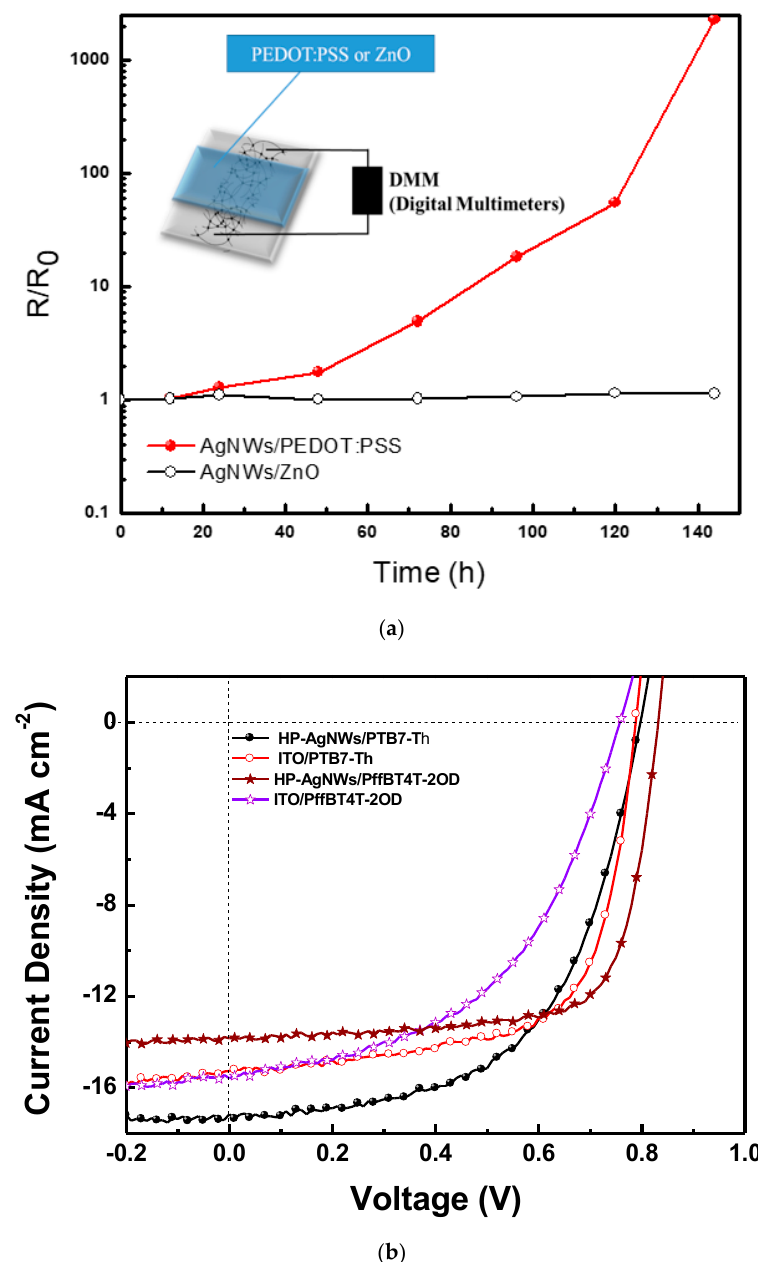
Figure 4. ( a ) Variation in R s of HP-AgNW/PEDOT:PSS and HP-AgNW/ZnO films under long-term storage in air; ( b ) J - V curves of PSCs made using ITO, HP-treated AgNWs and different active layers.